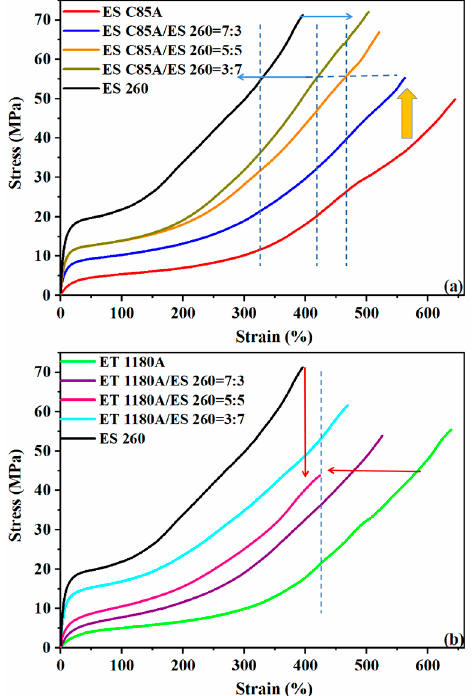
Figure 5. Stress vs. elongation traces of selected TPUs; change in behaviour with polyol type and